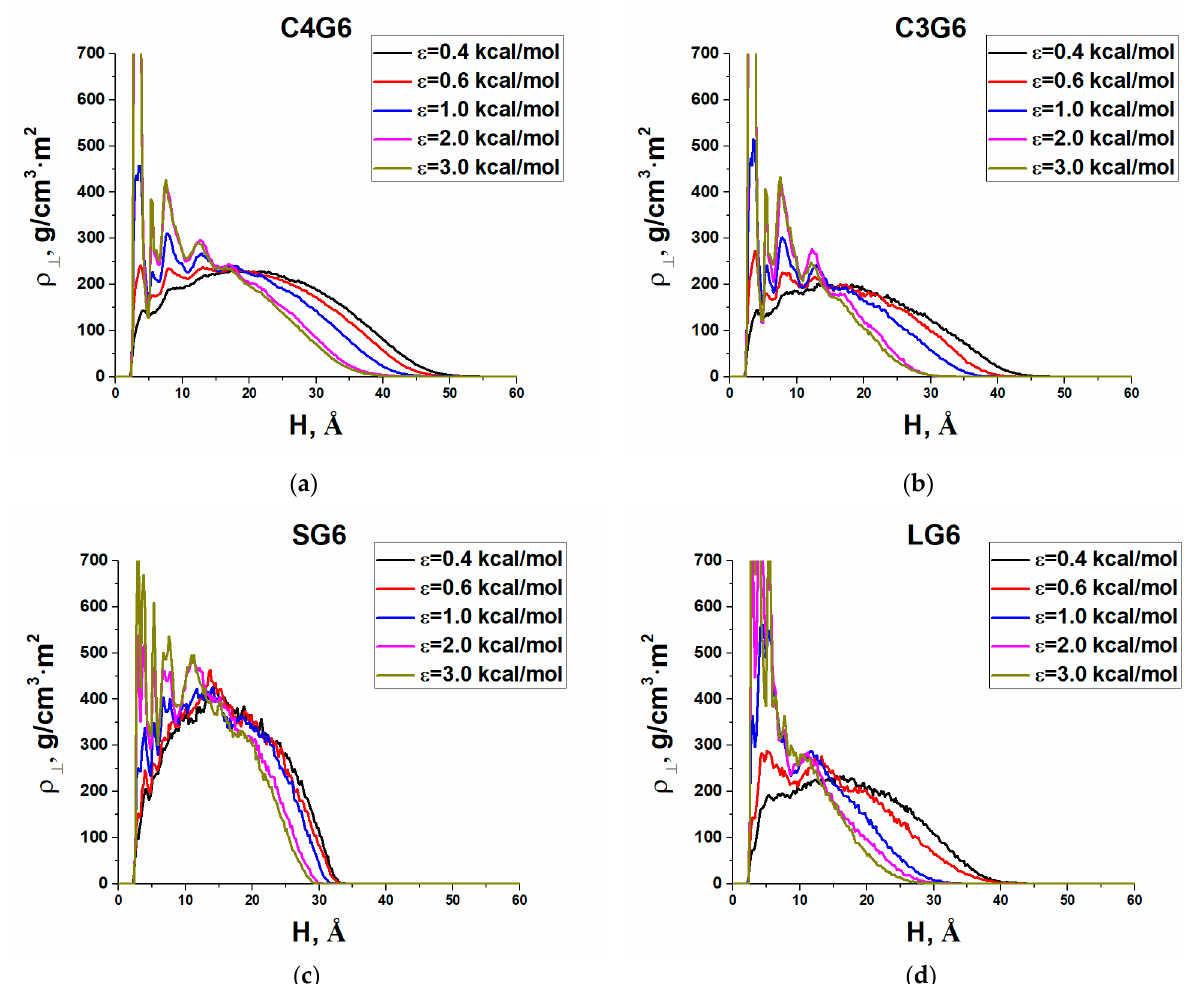
Figure 6. Density profiles ρ ⊥ perpendicular to the surface for the sixth generation of ( a ) the C4 dendrimer, ( b ) the C3 dendrimer, ( c ) the S-dendrimer, and ( d ) the L-dendrimer.